Question: Write a descriptive caption for this figure.
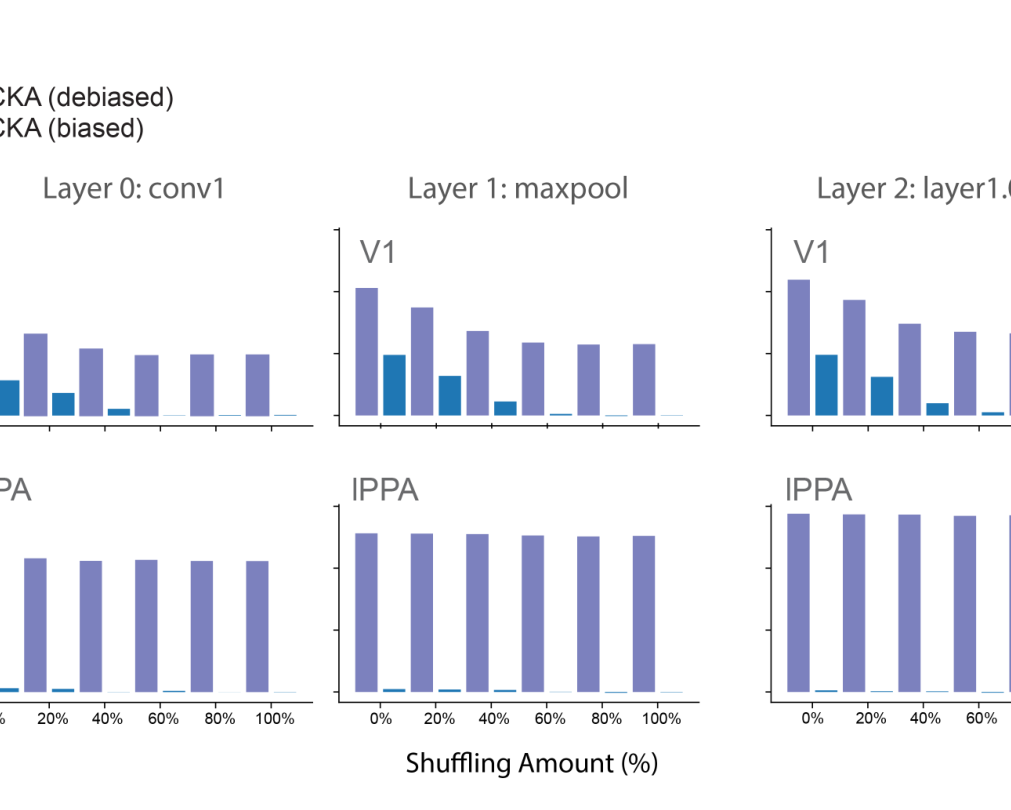
Answer: When no stimuli-driven alignment is detected (via debiased CKA) between brains and biological neural networks, biased CKA aligns equally as well to shuffled (neural) data as it to does to the original ordering. In ROIs where this occurs, no change is expected as the amount of shuffling is varied from 0% to 100%. Conversely, areas that do appear to contain stimuli-driven alignment should gradually decrease in alignment score as the amount of shuffling is increased. From Fig- ure 4 we selected V1 and left PPA (lPPA) to be representative of the two cases (V1: sensitive to stimuli-driven alignment, lPPA: insensitive to stimuli-driven alignment). We incrementally varied the percentage of shuffled items and measured the alignment in the first three layers of ResNet18 (conv1, maxpool & layer1.0.conv1). We find that the amount of shuffling has no effect on ANN-ROI pairs that originally showed no stimuli-driven alignment. We hypothesize that this is due to biased CKA’s sensitivity to